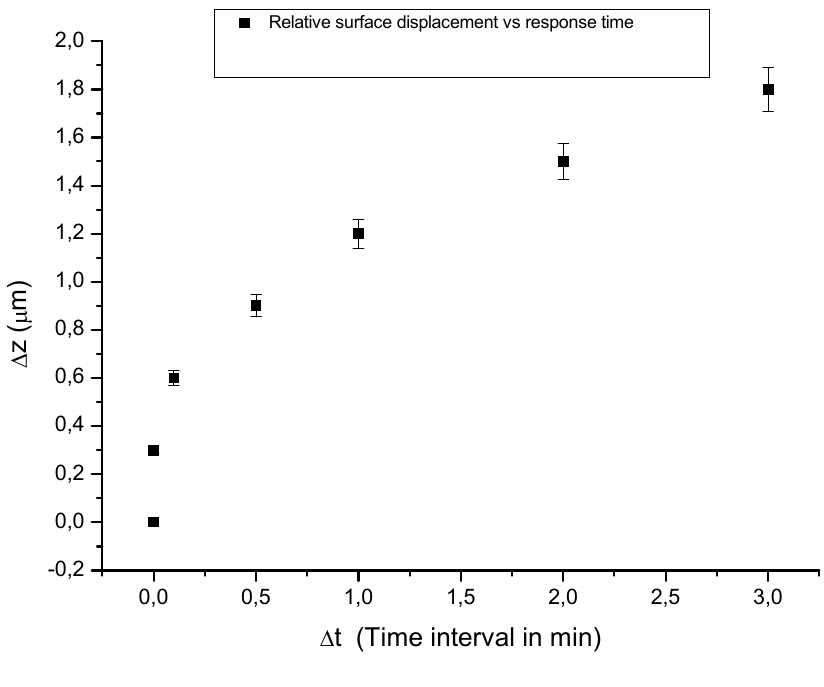
Figure 4. Smooth dimensional change is evident from surface displacement at specified times and relative displacement is low even following longer time intervals.